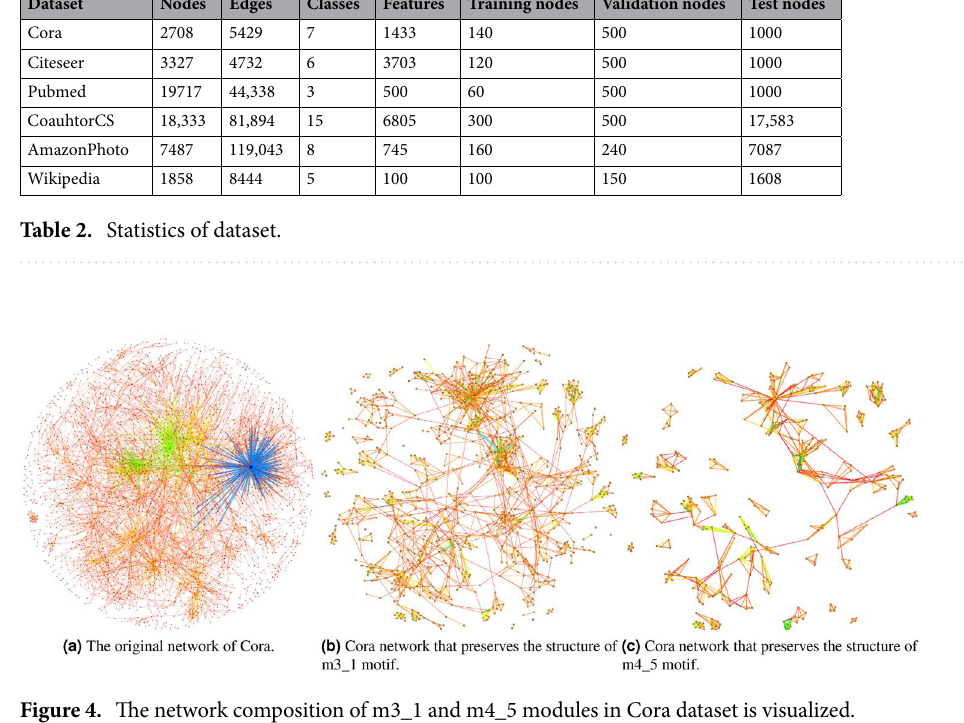
Figure 4. The network composition of m3_1 and m4_5 modules in Cora dataset is